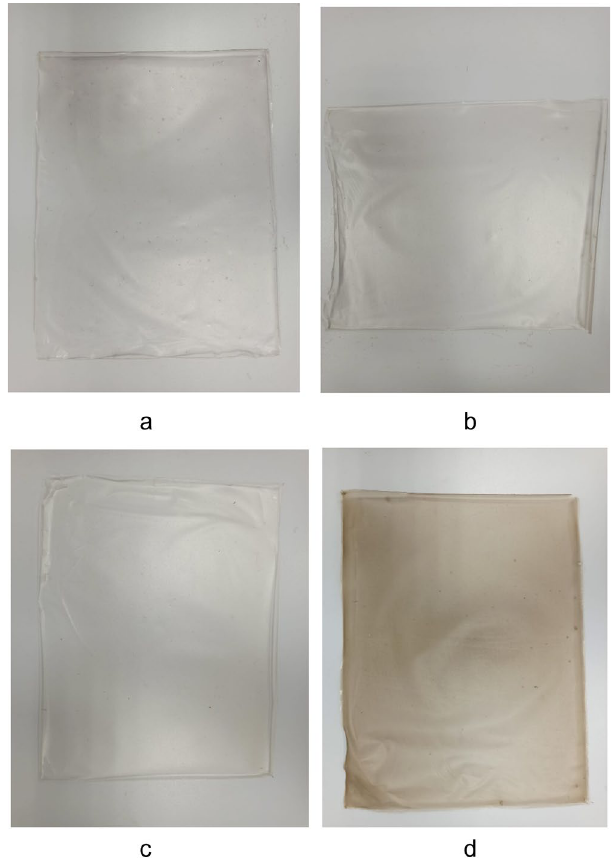
Figure 1. Photos of samples of methylcellulose films modified with CuO nanoparticles: a – control, b – 0.2%, c – 0.4%, d – 0.8%.